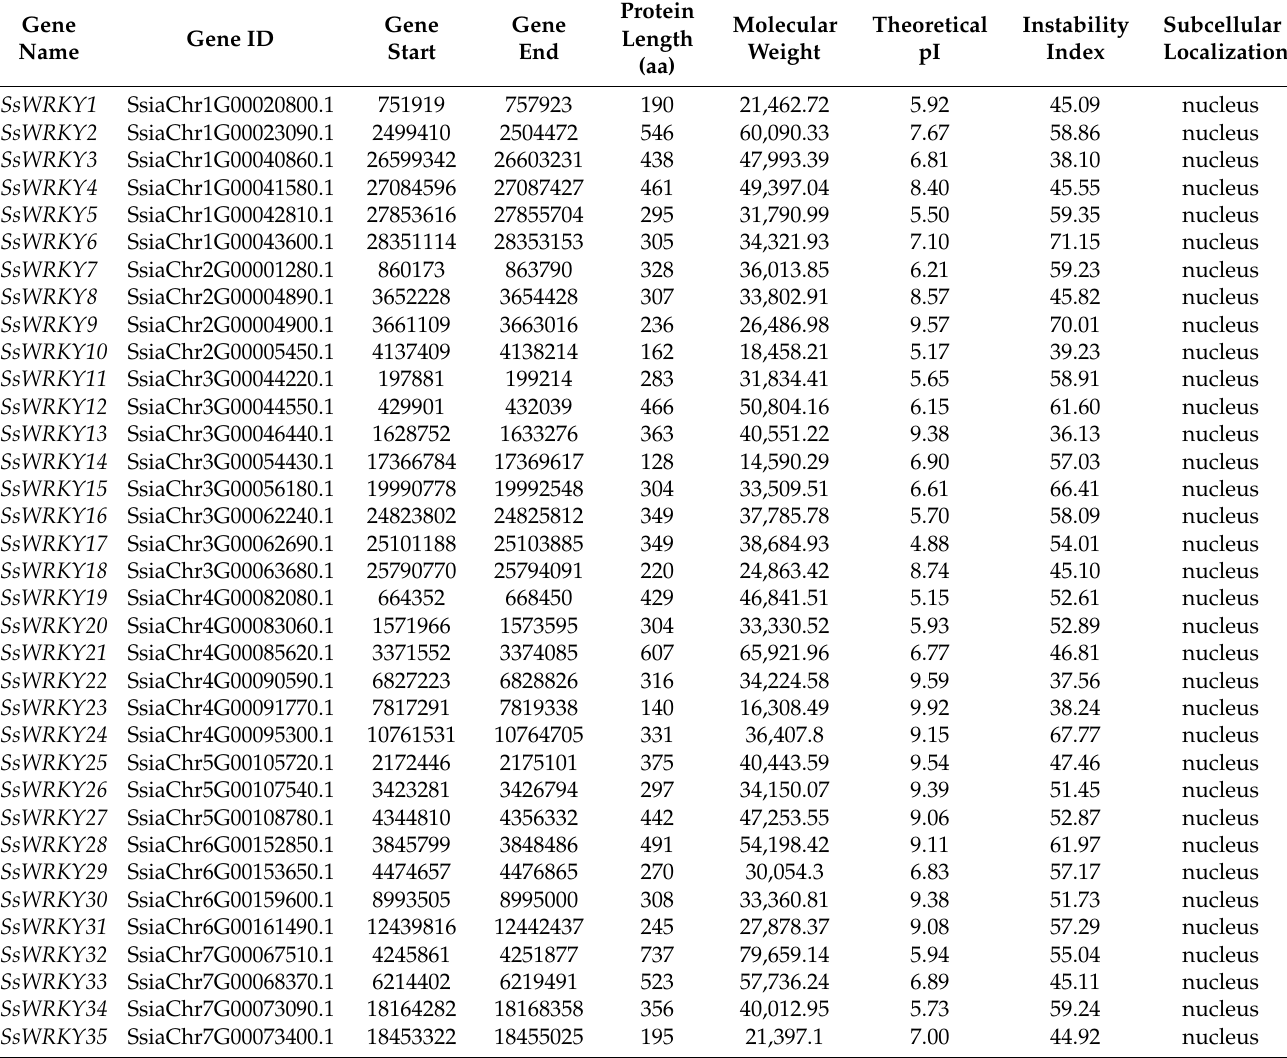
Table 1. Information for the WRKY transcription factor family in S. siamensis